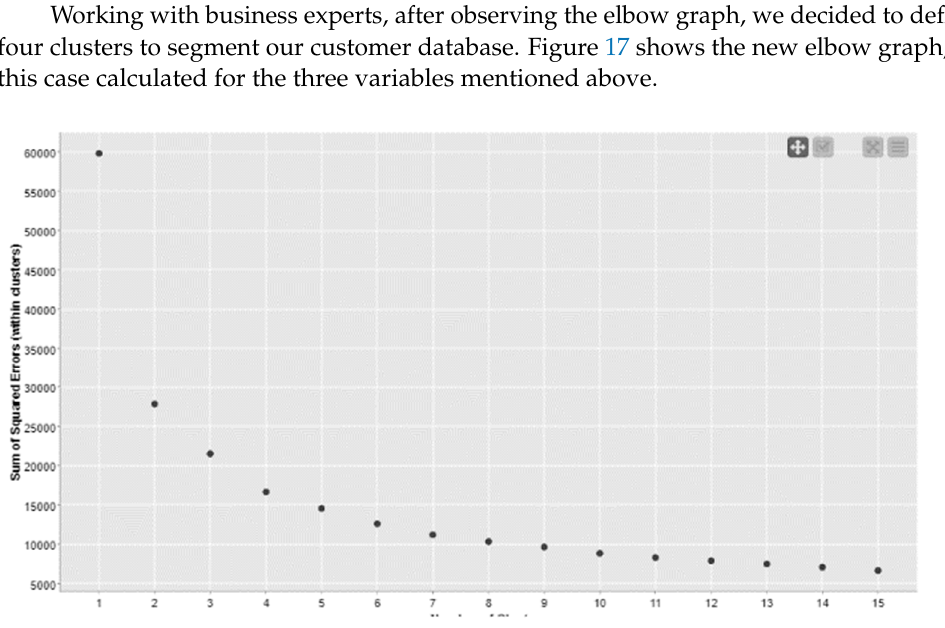
Figure 17. Elbow graph to decide the optimal number of clusters.